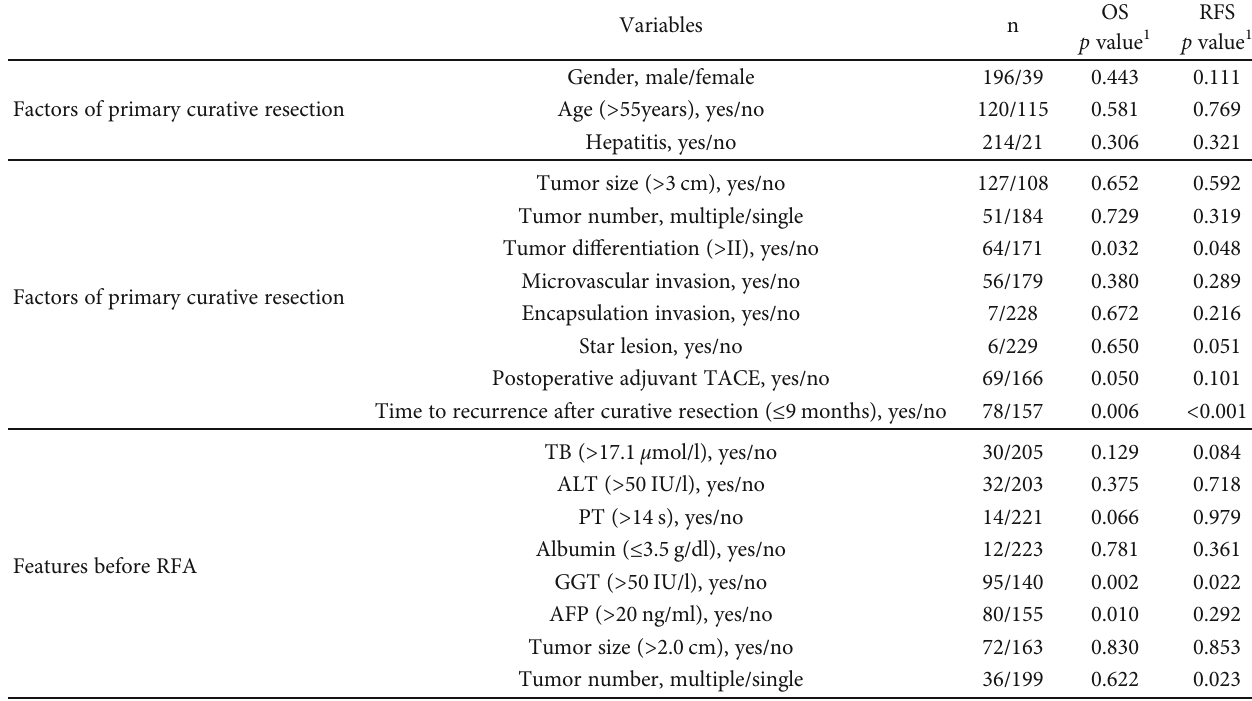
Table 1: Univariate analysis of the prognostic factors contributing to OS and RFS of recurrent HCC patients undergoing RFA. Variables